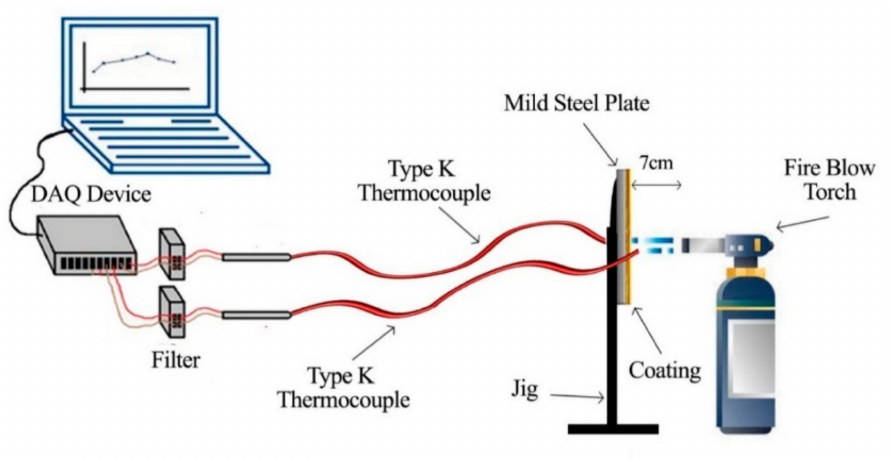
Figure 2. The fire resistance test illustration.